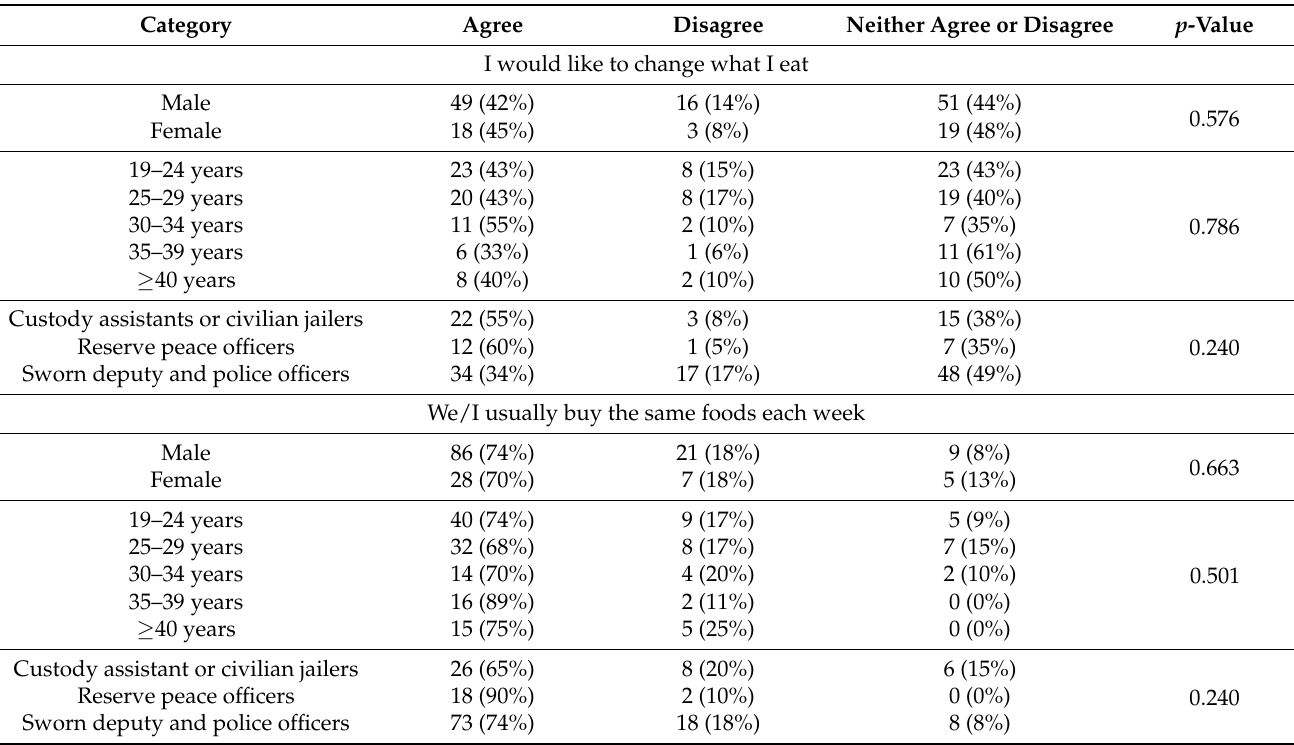
Table 1. The association between sex, age, and type of occupation and the dietary beliefs and behaviors of law enforcement